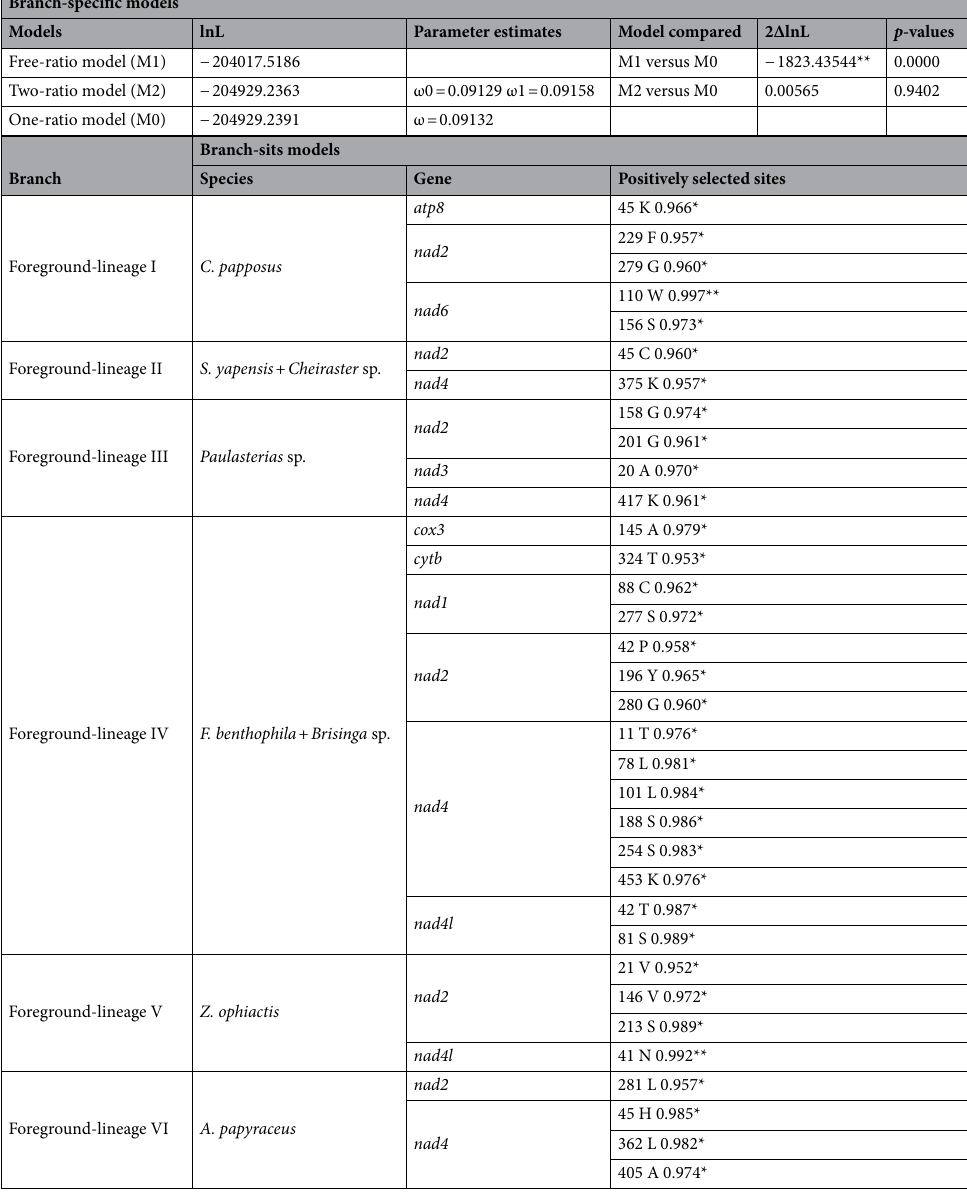
Table 2. Selective pressure analyses of the mitochondrial OXPHOS genes of asteroids. * 0.001 < p < 0.01 ** p <